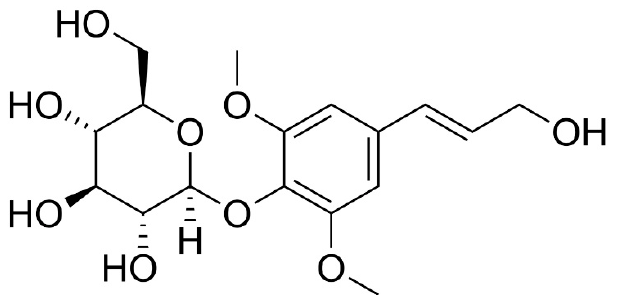
Figure 5. Structure of Eleutheroside B (syringine).